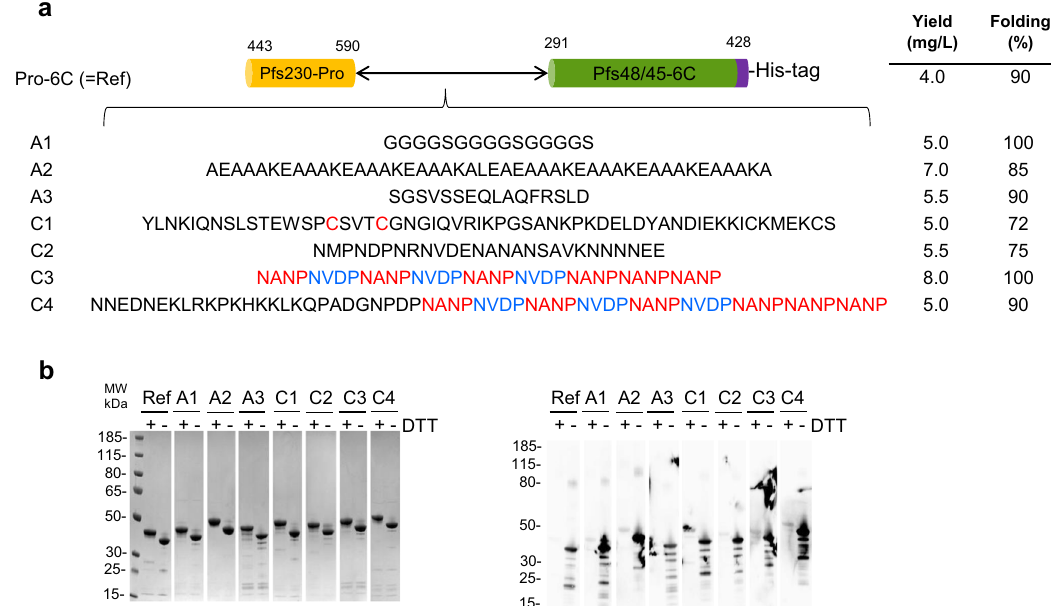
Fig. 1 Design and expression screening of Pro-6C chimeras. a Schematic representation of Pro-6C and different linker sequences. A panel of linker sequences (A1 – C4) were inserted between the two domains. b Coomassie blue-stained 4 – 12% polyacrylamide gel of puri fi ed proteins from 0.5 L-scale fermentation. Ref: Pro-6C. c Immune-blotting analysis of the same gel using the conformational reduction-sensitive mAb45.1 as primary antibody. All blots and gel are derived from the same experiment and processed in parallel. Composite images are presented in panels ( a ) and ( b ) from original images fi les provided in Supplementary Figure S4 and S5,